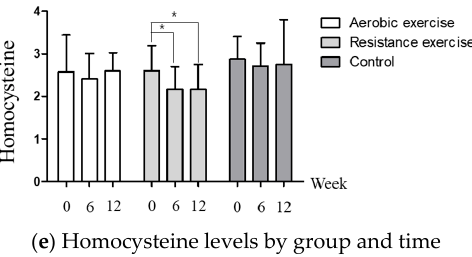
Figure 1. Cognitive reserve biomarker levels by group and time ( a ) NGF, group: 2.442 (0.102), time: 13.201 (<0.001), group × time: 1.224 (0.309). ( b ) BDNF, group: 2.614 (0.088), time: 19.595 (<0.001), group × time: 5.304 (0.001). ( c ) Cathepsin B, group: 0.080 (0.924), time: 11.981 (<0.001), group x time: 2.131 (0.087). ( d ) Beta-Amyloid 1–42, group: 0.291 (0.751), time: 3.837 (0.031), group × time: 8.475 (<0.001) ( e ) Homocysteine, group: 0.907 (0.422), time: 1.801 (0.181), group × time: 0.750 (0.565). * p -value was analyzed by post hoc (Bonferroni test), * p < 0.05, ** p < 0.01, *** p < 0.001